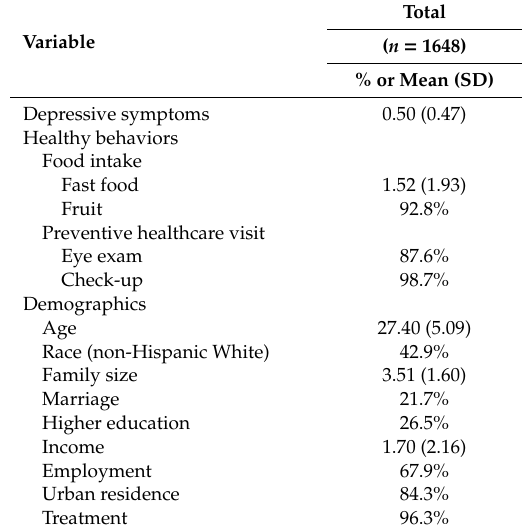
Table 1. Descriptive statistics for variables included in the study.